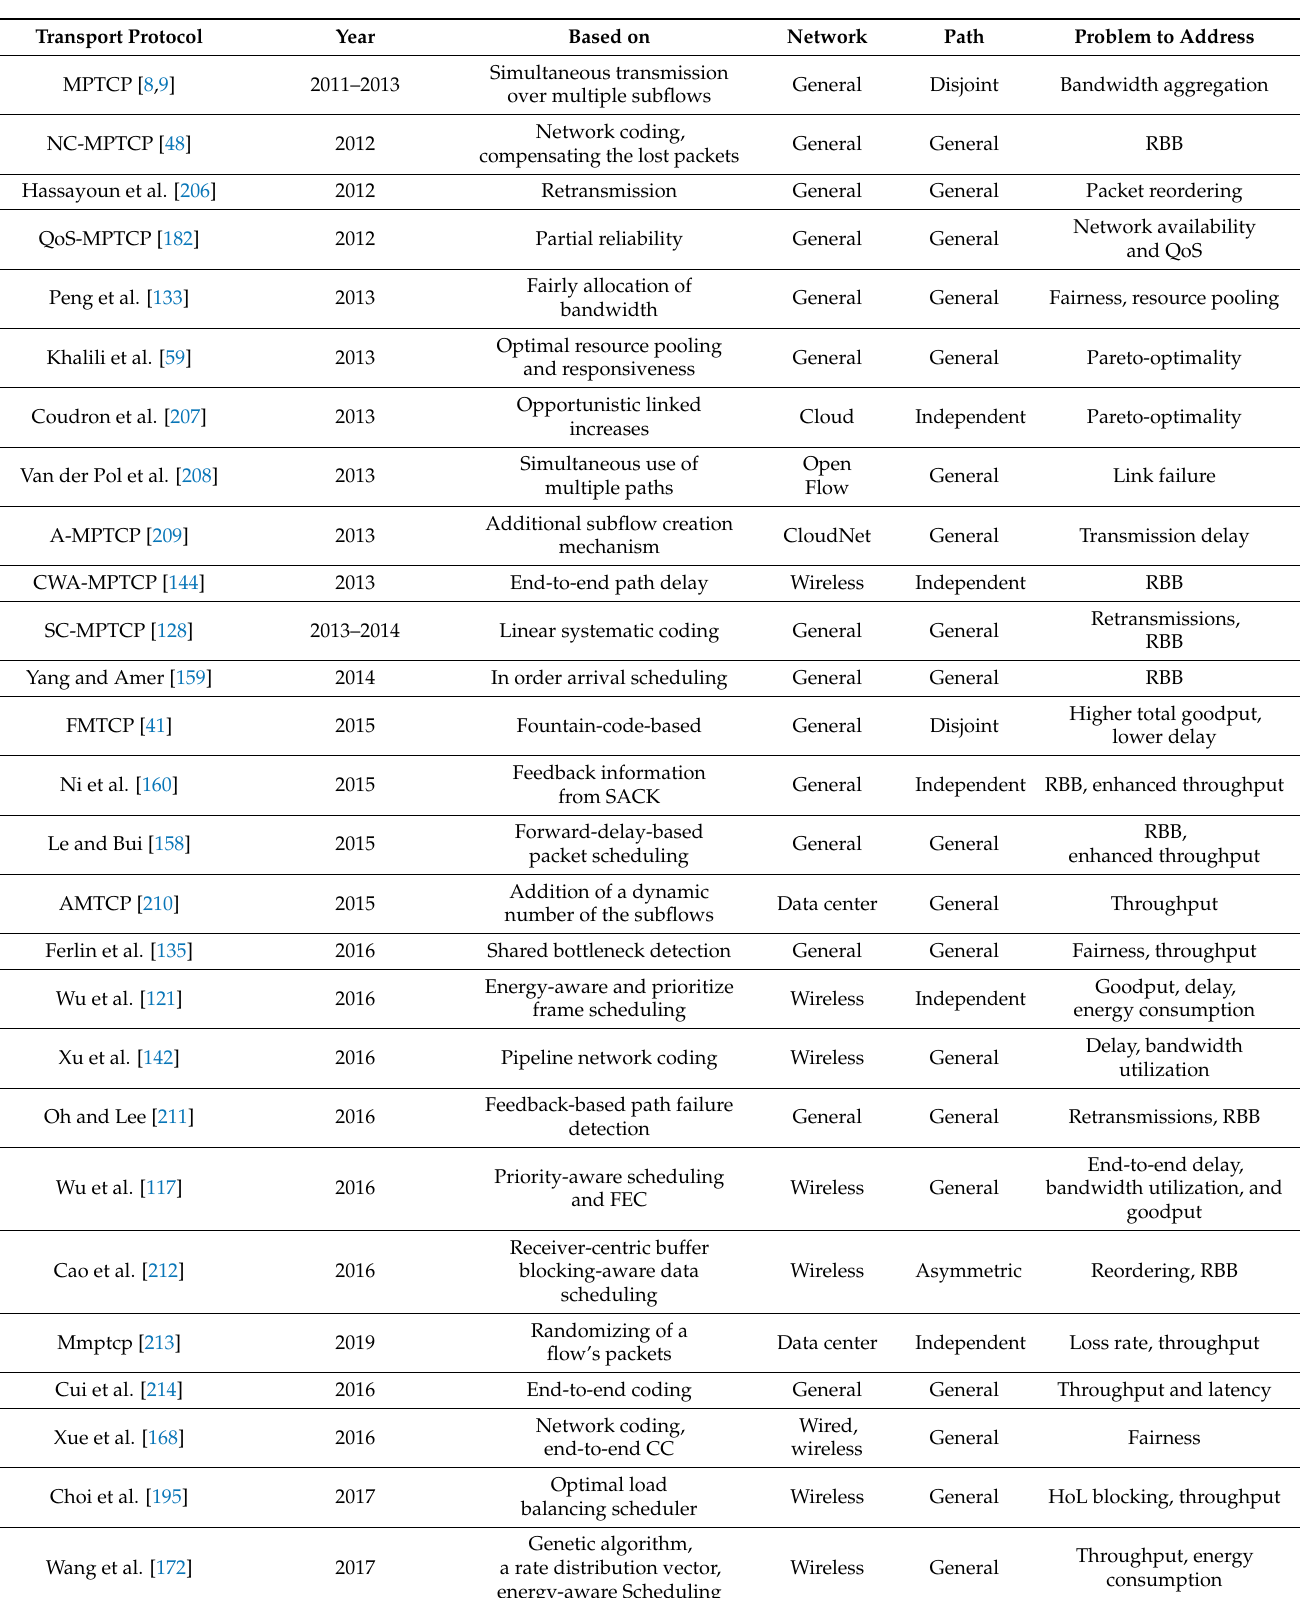
Table 4. MPTCP transport